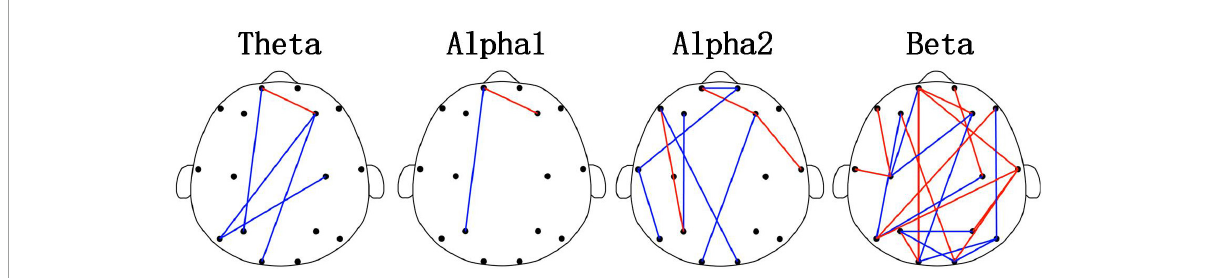
FIGURE3 Differential functional connectivitys (FCs) ( p < 0.05) between the Old_GAD and Young_GAD for four rhythms (theta, alpha1, alpha2, and beta). The red edge meant that the weight of the phase-lag-index (PLI) value in Old_GAD is higher than that in the Young_GAD, and the blue was the opposite.